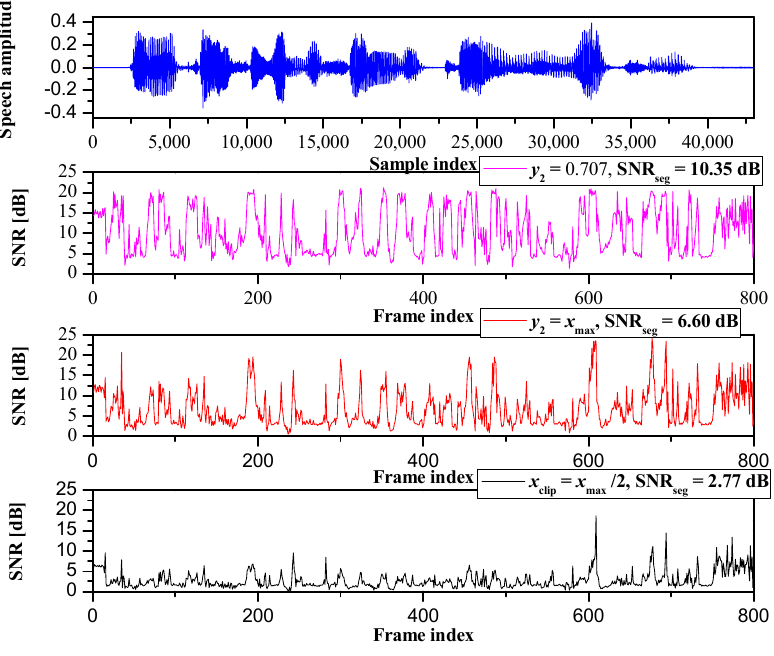
Figure 12. SQNR across speech frames in the case of adaptive delta modulation (ADM).